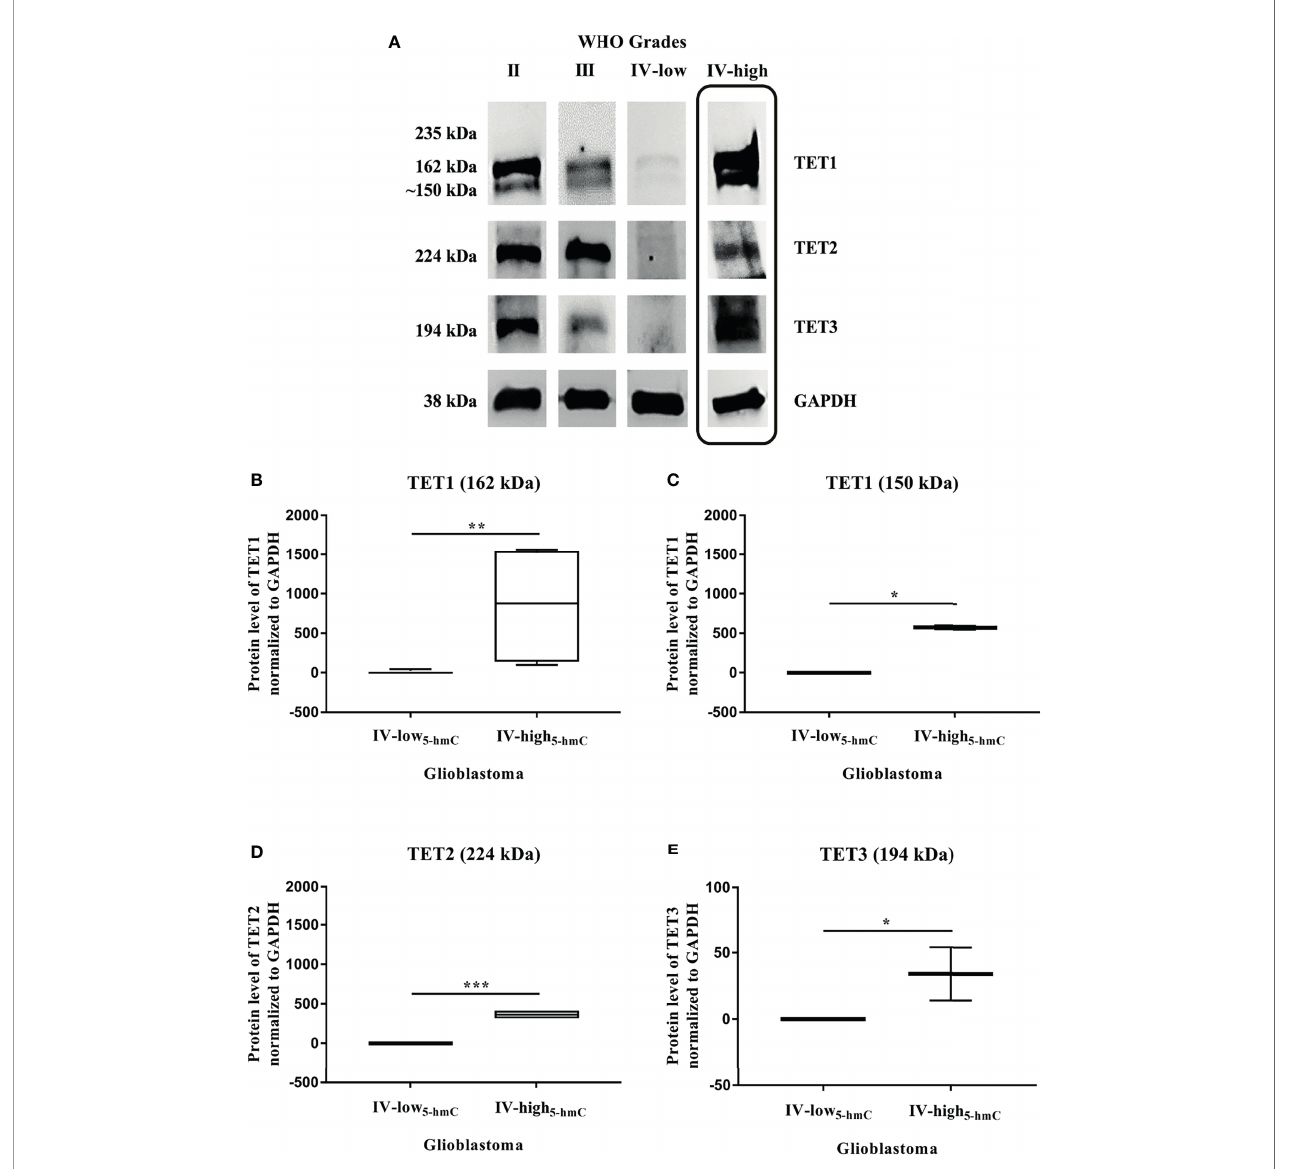
FIGURE 3 | TET proteins expression in gliomas. Western blot analysis of TET proteins (A – E) . Exemplary immunoblots of TET1, TET2, and TET3 proteins pictured loss of their expression across glioma stages, except some Grade IV samples (last column). Expression levels of these proteins were normalized with GAPDH (A) . High variability in protein levels of TET1 (B, C) , TET2 (D) and TET3 (E) correlated with 5-hmC abundance across glioblastoma (Grade IV-low 5-hmC and Grade IV- high 5-hmC ). Differences between two groups were evaluated by Mann-Whitney U test (*p < 0.05, **p < 0.01, ***p <